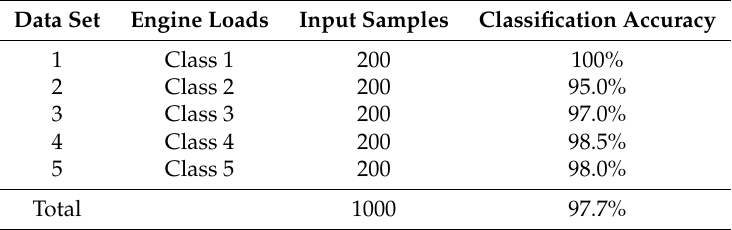
Table 3. Classification accuracy of the trained network on other unseen data sets.